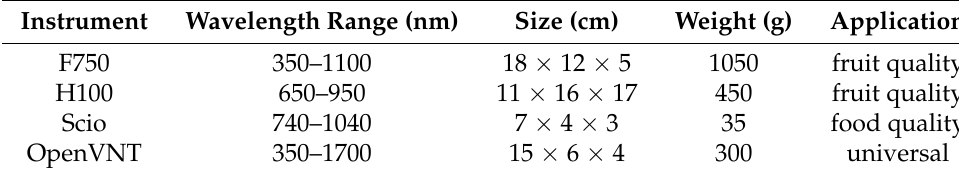
Table 5. Comparison of instruments by wavelength range and form